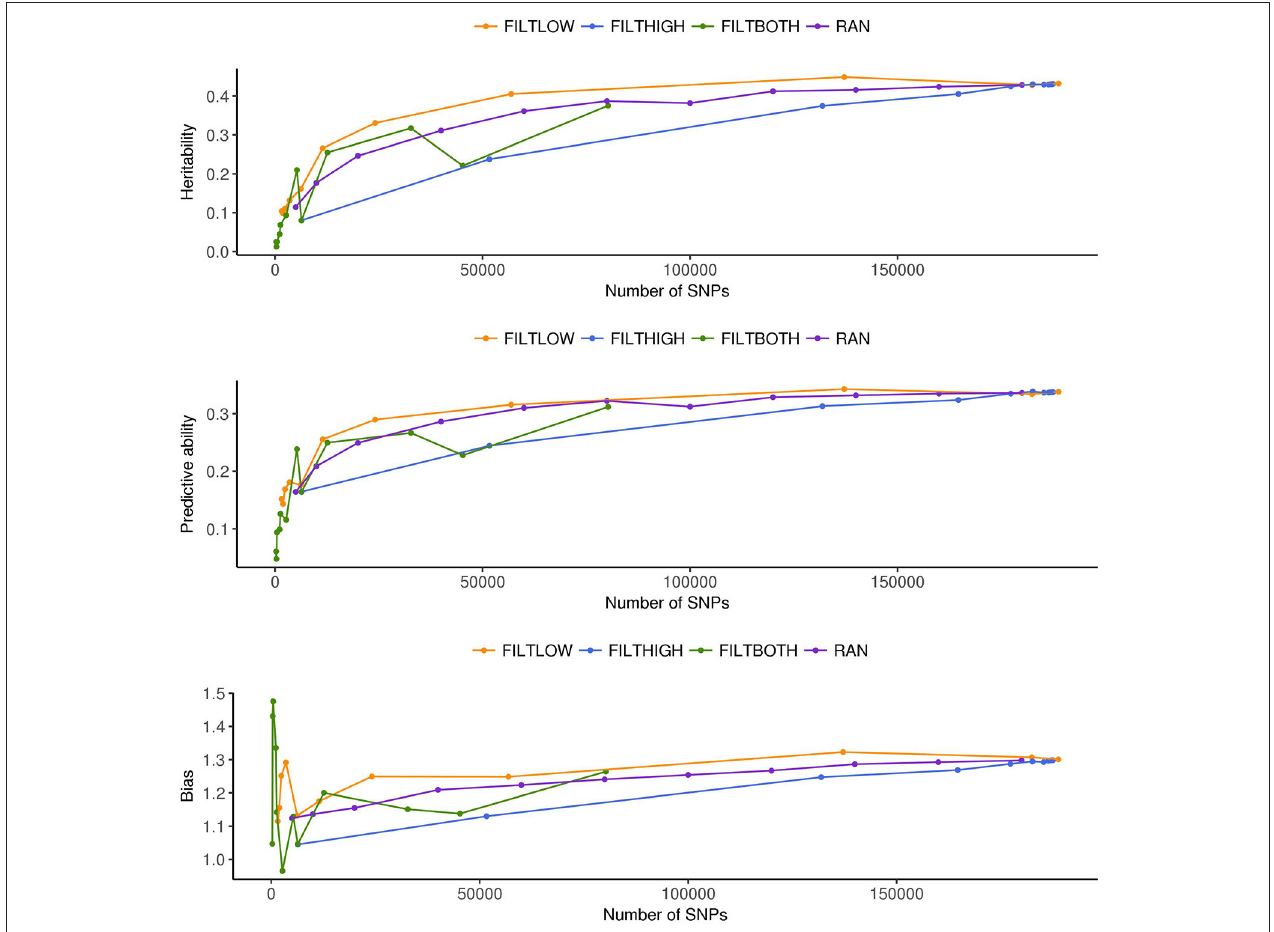
FIGURE 3 | Estimated heritability, predictive ability and bias in different SNP filtering scenarios 1 for dry matter yield. 1 FILTLOW, strategy filtering out SNPs having low average depth; FILTHIGH, strategy filtering out SNPs having high average depth; FILTBOTH, strategy filtering out SNPs having both low average and high average depth; RAN, strategy keeping SNPs randomly with different data